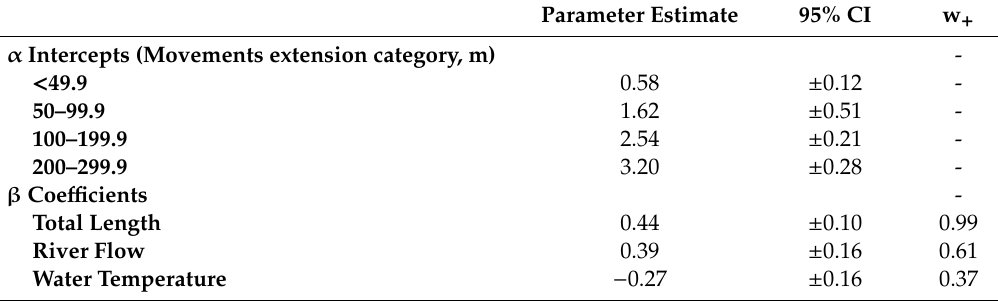
Table 3. Results of Multi-model inference from the models TL-RF and TL-WT ( ∆ AICc < 2). Parameter estimates, 95% C.I. and the relative importance of each variable (w + ) (Total Length, River Flow and Water Temperature) for the odds and extent of eel movements (m) in the Guadiaro River population between October 2014 and June 2016. Parameter Estimate 95%